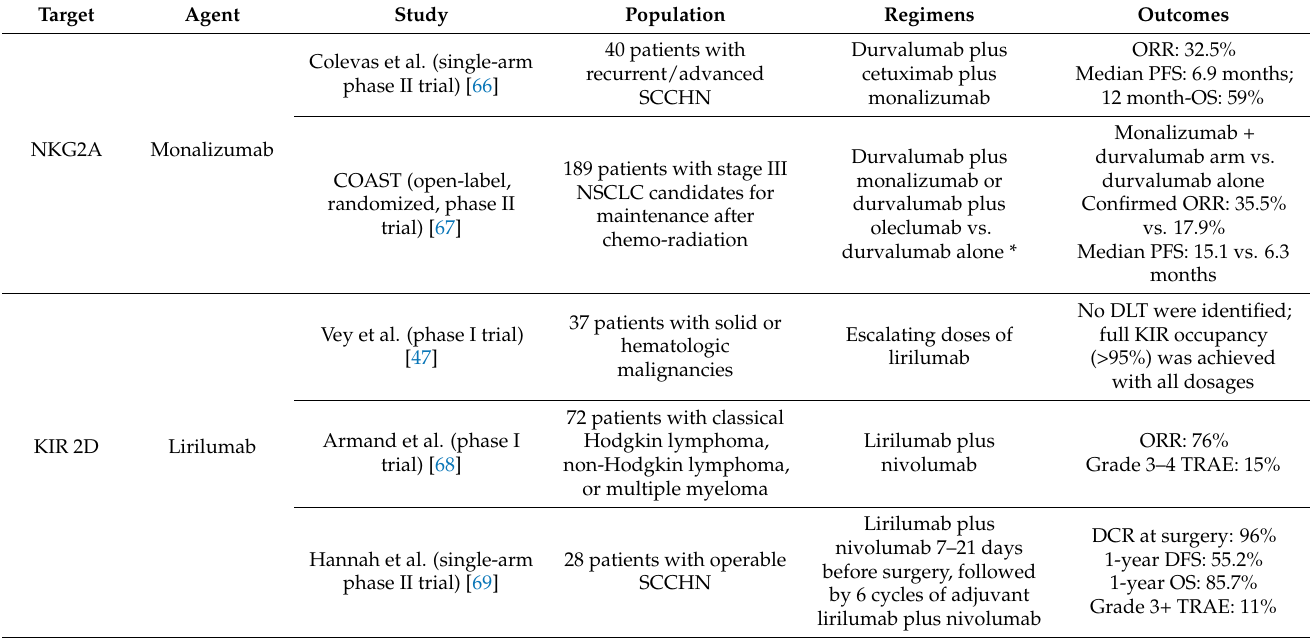
Table 1. Relevant clinical data of immune checkpoint inhibitors specifically designed to enhance anti-neoplastic NK cell activity. Legend -> DCR: disease control rate; DLT: dose-limiting toxicity; DFS: disease-free survival; NSCLC: non-small cell lung cancer; SCCHN: squamous cell carcinoma of head and neck; OS: overall survival; PFS: progression-free survival; TRAE: treatment-related